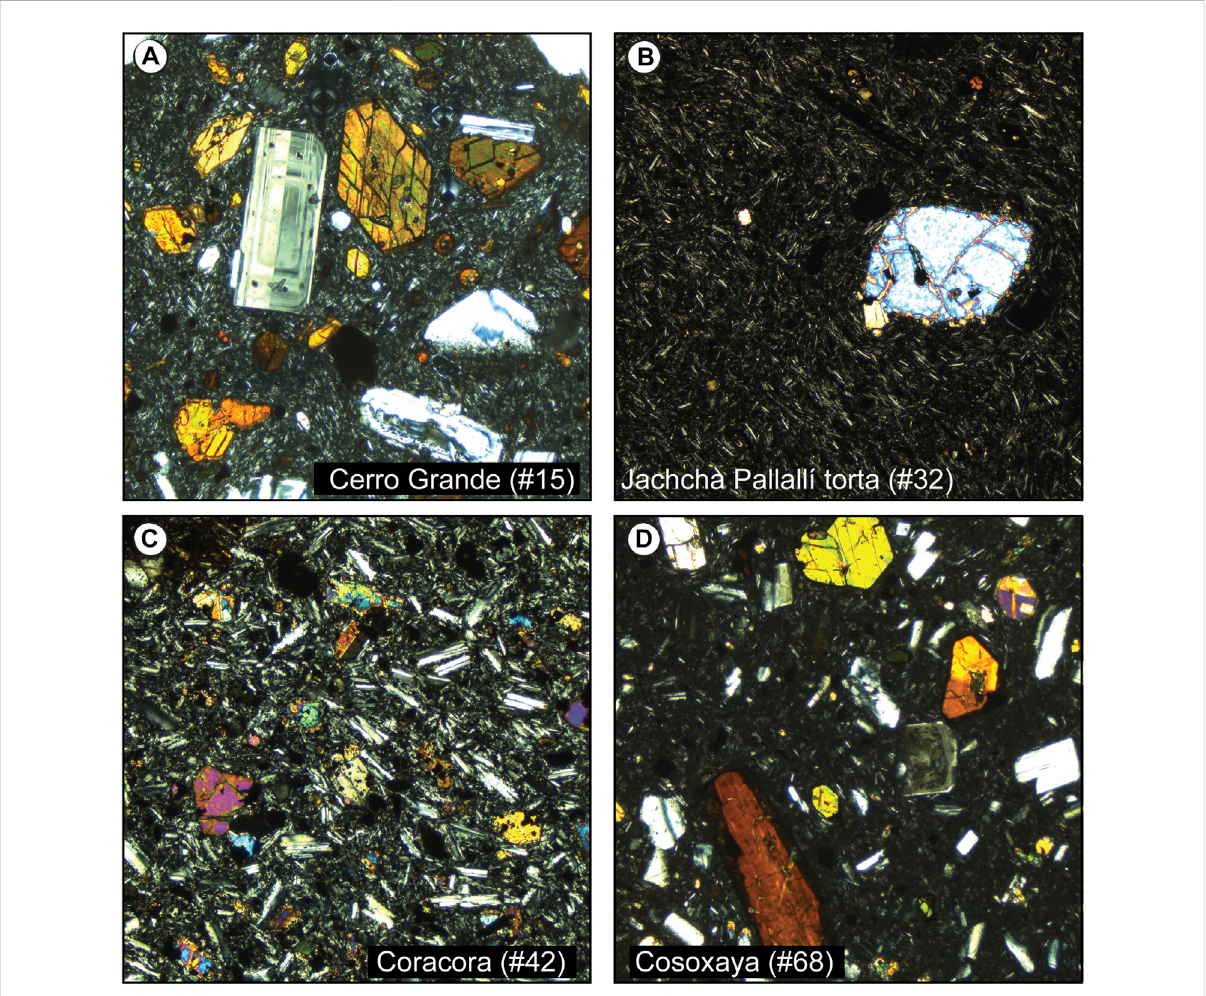
FIGURE 6 Photomicrographsincross-polarizedlightofrepresentativepetrographicfeaturesofIntersalarRangelavas.Fieldofviewisapproximately2 mm for each image. (A) Highly porphyritic lava from Pliocene Cerro Grande lavas (sample #15) with phenocrysts of plagioclase and amphibole, typical of silicic composite centers. (B) Olivine phenocryst and groundmass from the Pliocene phenocryst-poor trachyandesite Jachcha Pallallí torta